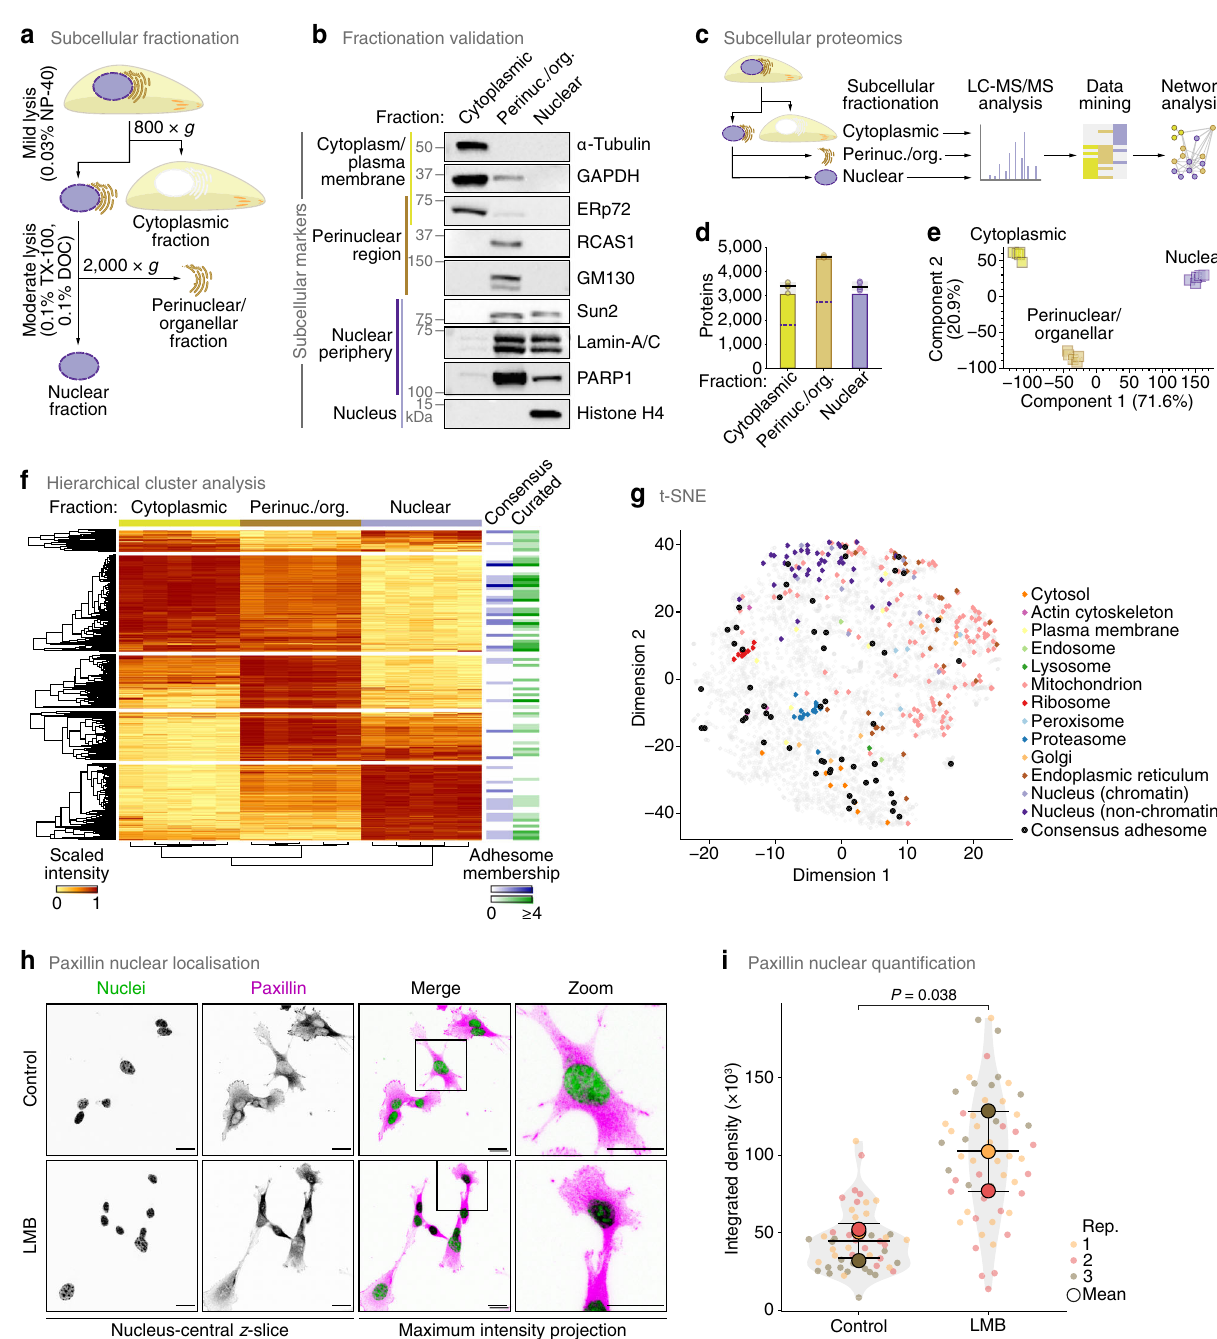
clusters based on protein abundance (Fig. 2f) and intersample correlation (Supplementary Fig. 2b), con fi rming that the different subcellular fractions were quantitatively distinct. Indeed, the nuclear subproteome was de fi ned by a distinct cluster of nucleus- enriched proteins that was depleted of cytoplasmic proteins (Fig. 2f), and subcellular marker proteins generally partitioned according to subcellular location (Fig. 2g, Supplementary Fig. 2d). nuclear marker proteins in t-SNE space (Fig. 2g), possibly re fl ecting the reported localisation of a subset of